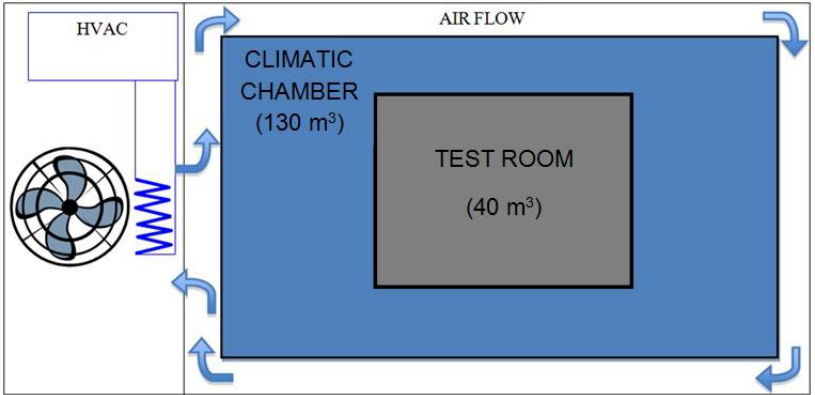
Figure 3. A schematic of the test facility arrangement. The climatic chamber acted as the cold-room, while the inner test room was used as the warm one.